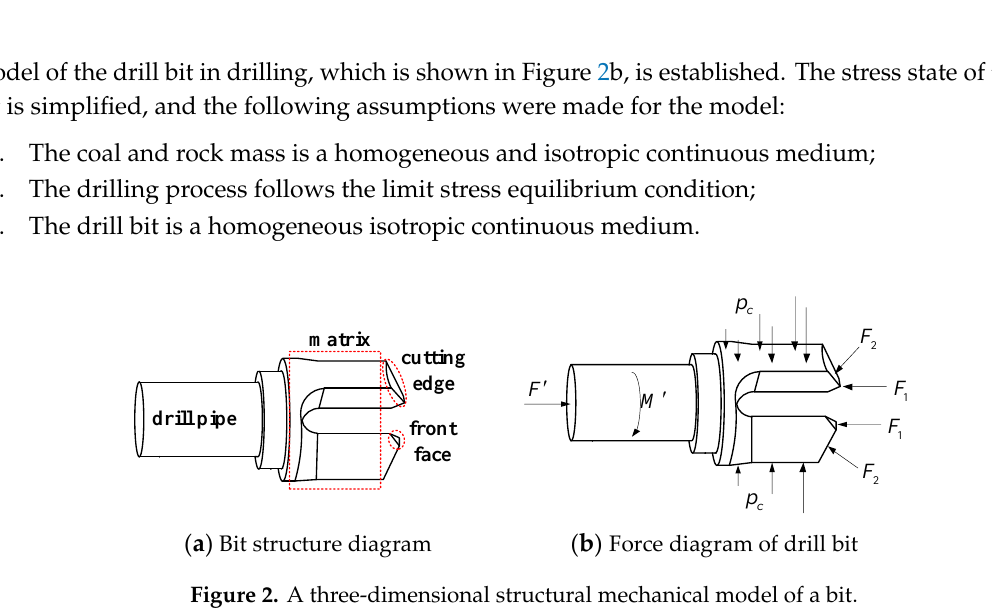
Figure 2. A three-dimensional structural mechanical model of a bit.